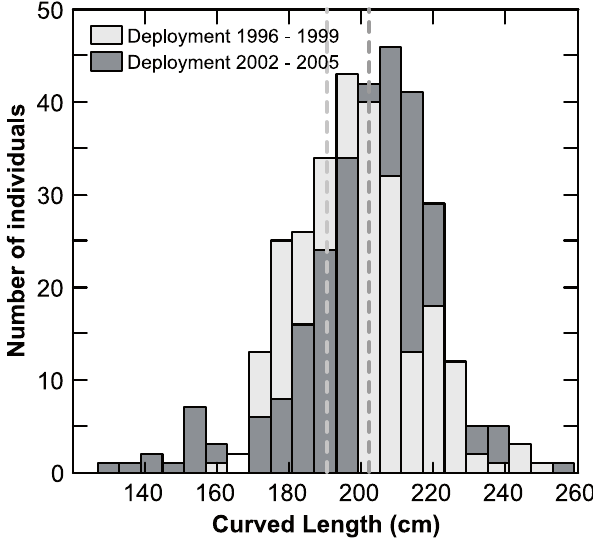
Figure 1. Size distribution of tagged bluefin tuna at deploy- ment between 1996–1999 (mean 6 sd; 198.3 6 16 cm CFL; n=280; light grey bars), and 2002–2005 (203.2 6 19 cm CFL; n=281; dark grey bars). Dotted lines indicate corresponding